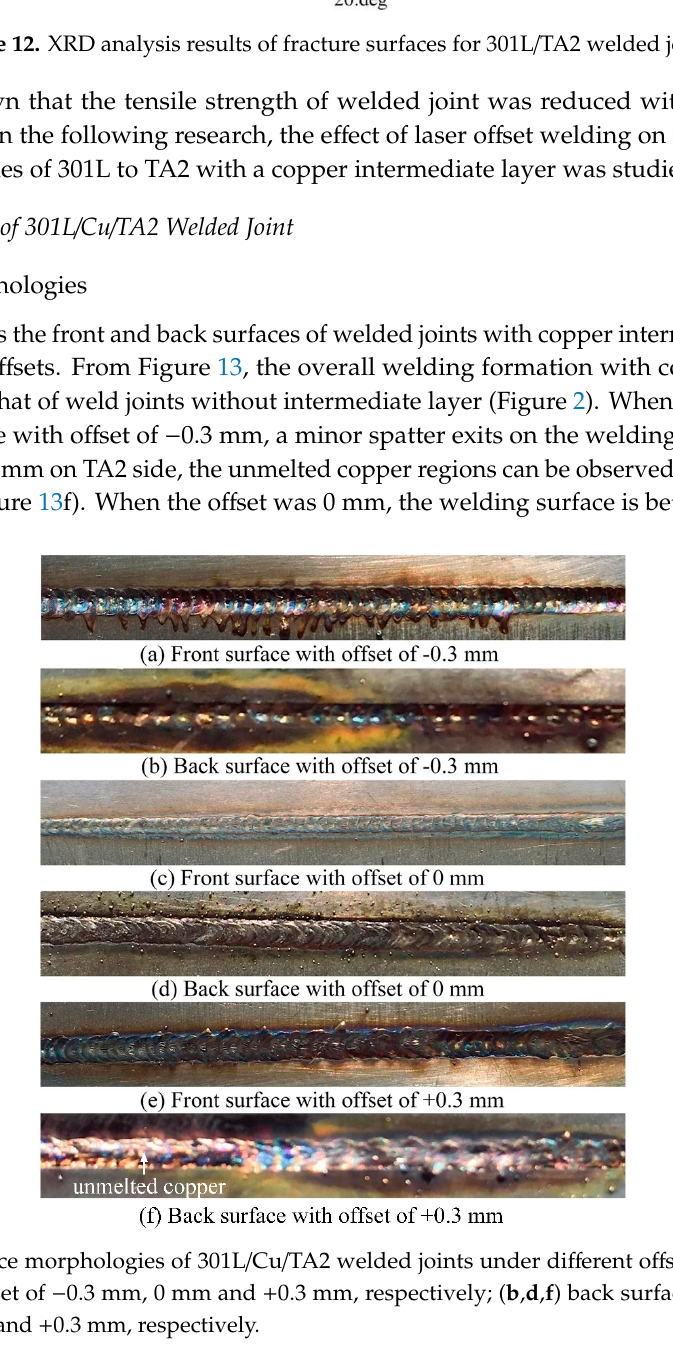
Figure 12. XRD analysis results of fracture surfaces for 301L/TA2 welded joints.